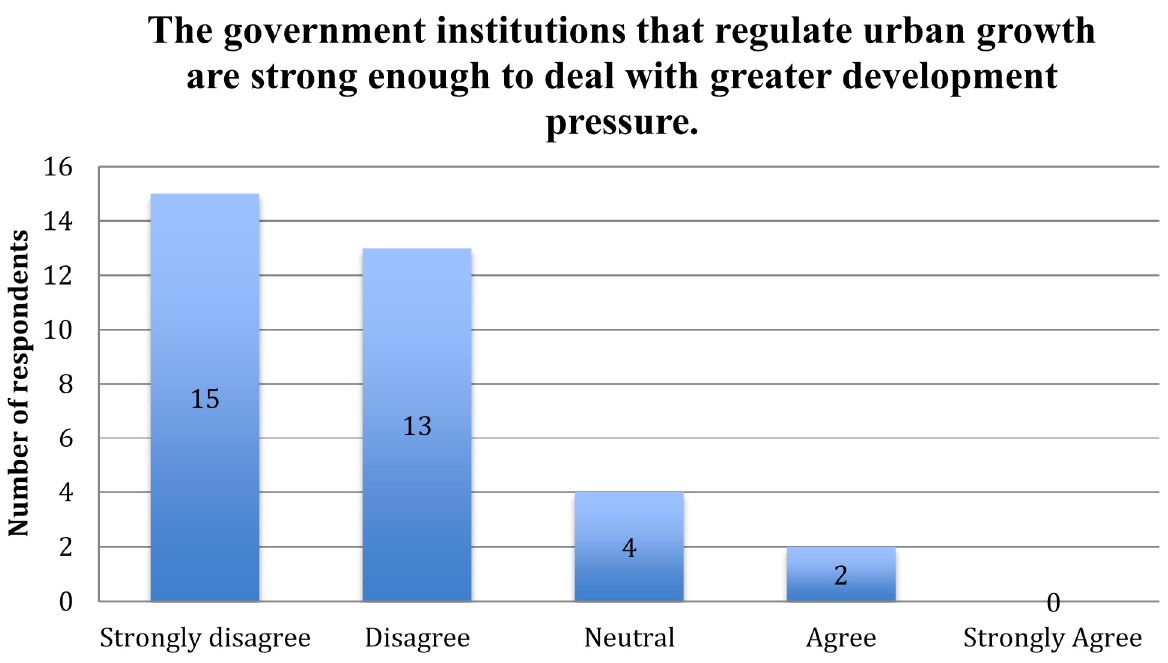
Figure 2. Graph of responses to survey question about trust in government institutions to regulate urban